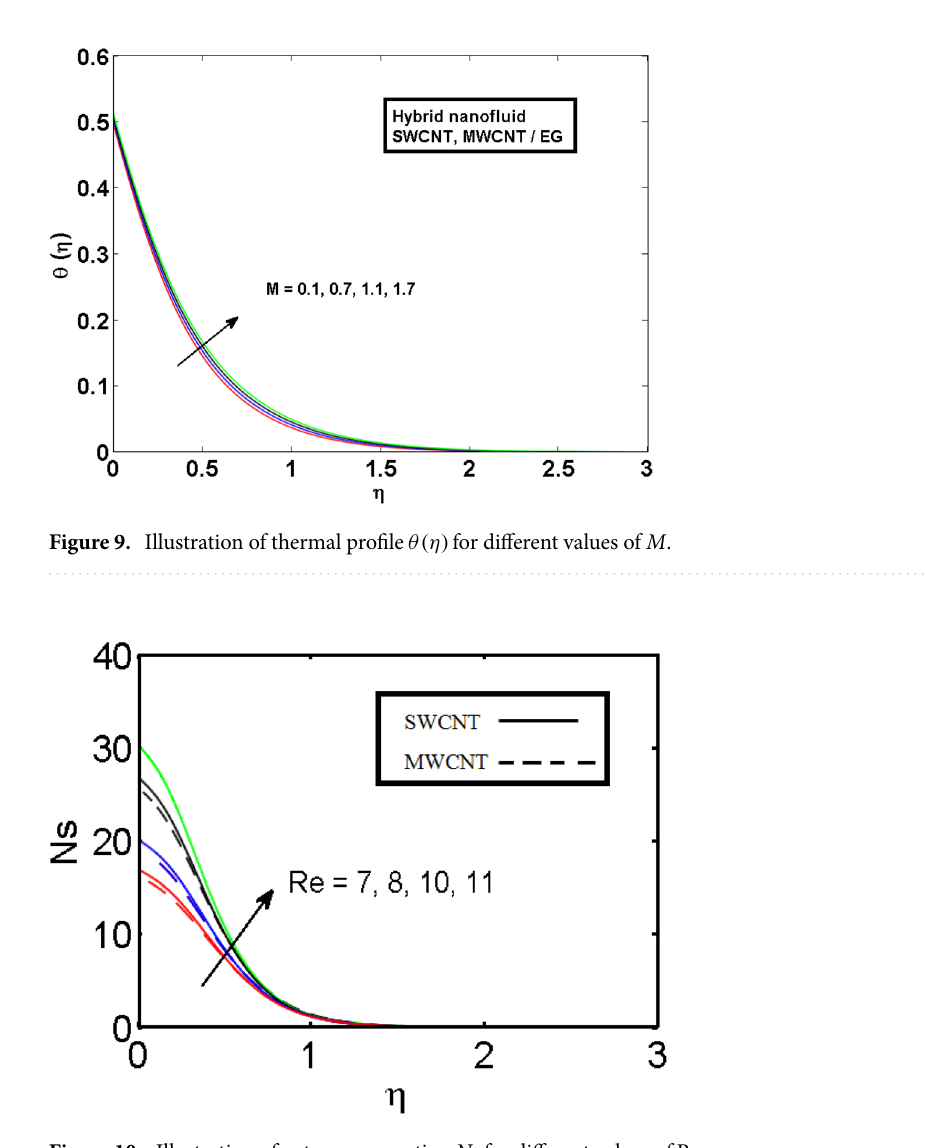
Figure 10. Illustration of entropy generation Ns for different values of Re